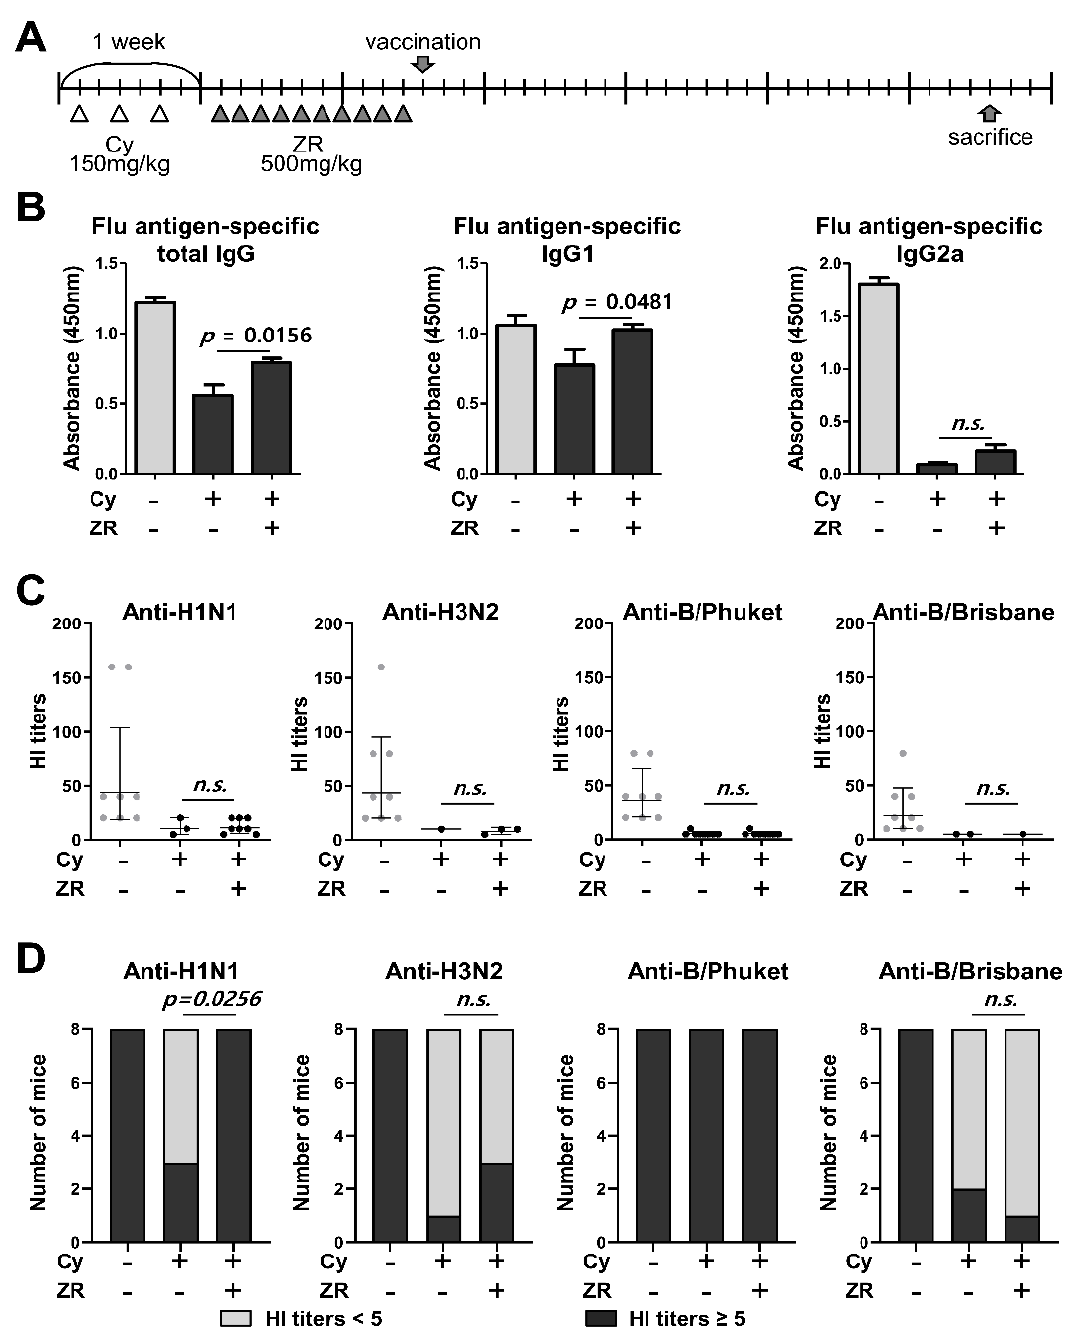
Figure 2. Evaluation of antibody responses to an influenza vaccination in ZR-administered immuno- suppressed mice after flu vaccination. ( A ) Mice were intraperitoneally injected with Cy on days 1, 3, and 5 in the first week; mice injected with Cy (150 mg/kg) were then orally administered distilled water ( n = 8, Cy group) or 500 mg/kg ZR ( n = 8, Cy + ZR group) for 10 days, following vaccination with the 2017/2018 seasonal quadrivalent flu vaccine. The effect of ZR on antibody response after 4 weeks is shown. ( B ) Influenza-specific antibody titers (total IgG, IgG1, or IgG2) were measured using the enzyme-linked immunosorbent assay. ( C , D ) Influenza subtype-specific hemagglutination inhibition (HI) titers were measured using the HI assay. Non-treated mice were used as controls ( n = 8, non-treated group). Cy, cyclophosphamide; ZR, Zingiberis Processum Rhizoma . Statistical analysis was performed using Student’s t -test and Fisher’s exact